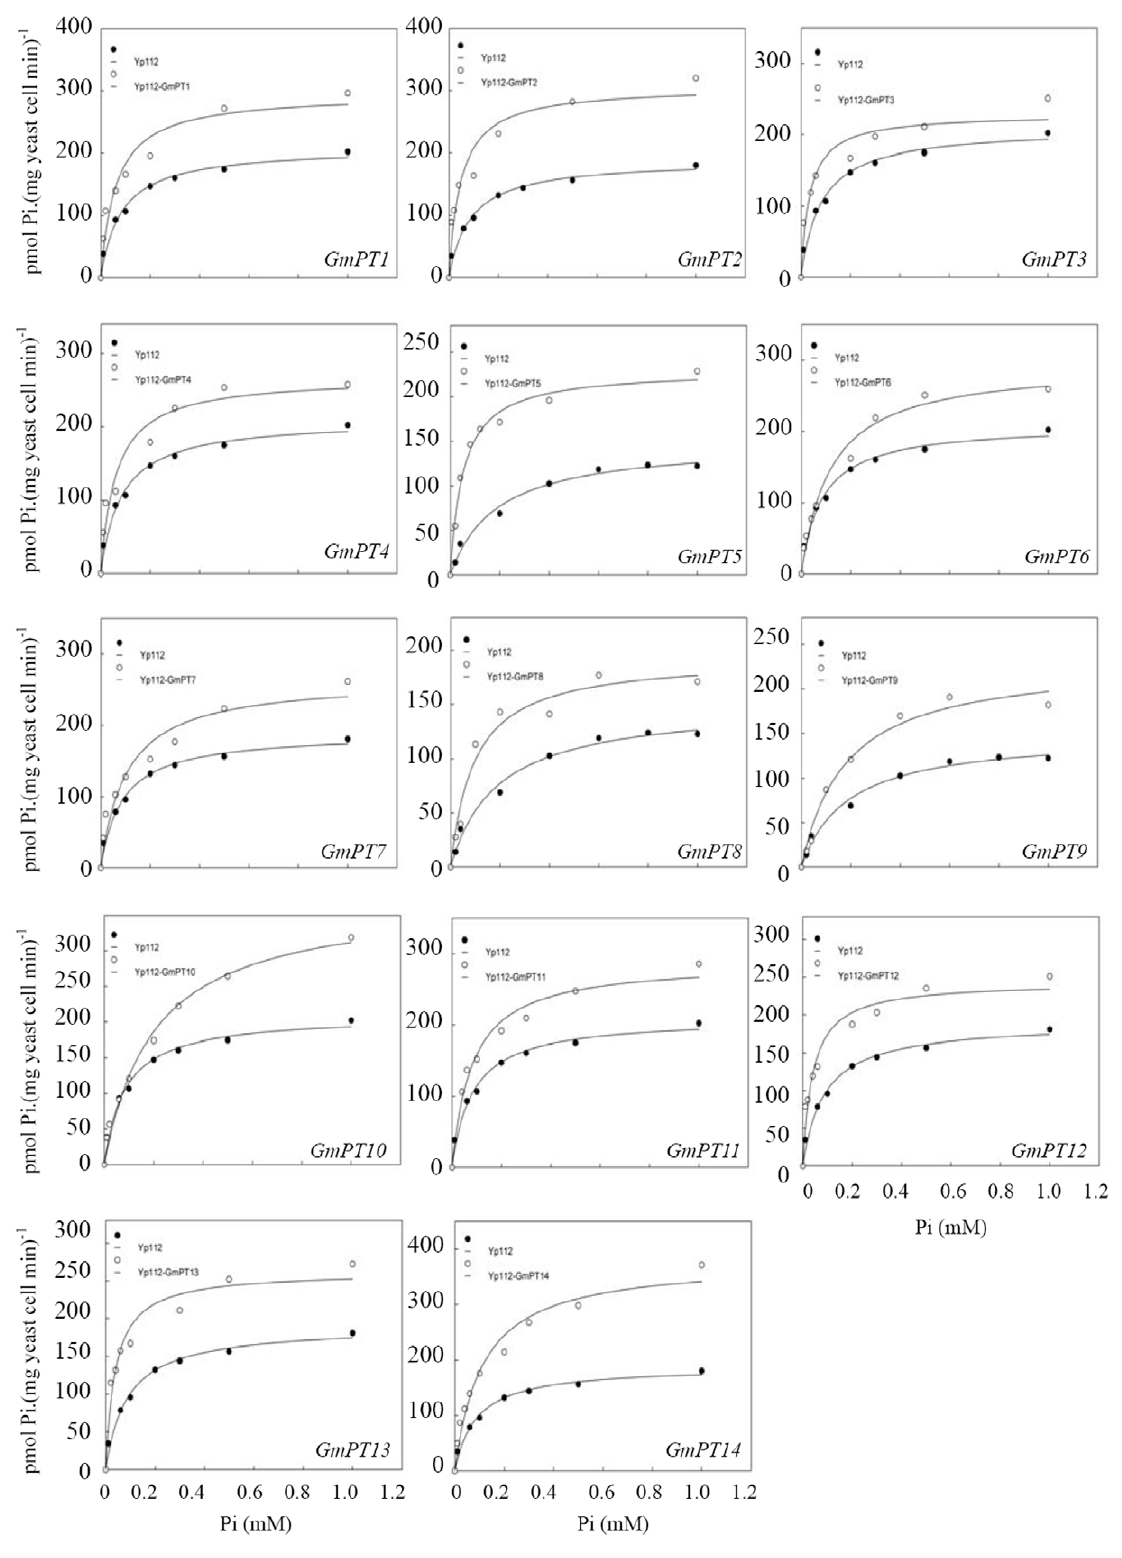
Figure 3. Kinetic analysis of inorganic phosphate (Pi) uptake in yeast. The non-linear regression of total Pi uptake by strain Yp112-GmPTs versus external Pi concentration at pH 6 were used to estimate the apparent Km value for Pi uptake. All the results were calculated from the three independent experiments.